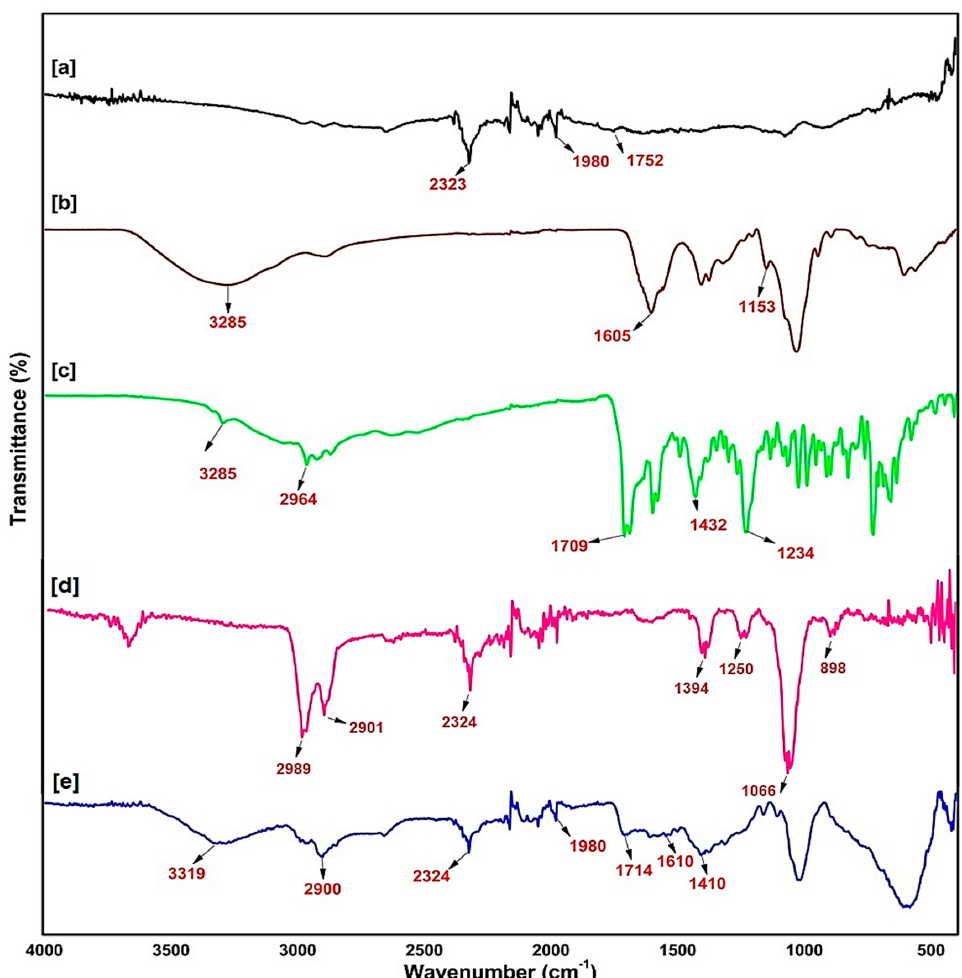
Figure 2. The Fourier transmittance infra-red spectrum of ( a ) SWCNTs, ( b ) HA, ( c ) Ce6, ( d ) SWCNTs-HA, ( e ) SWCNTs-HA-Ce6.